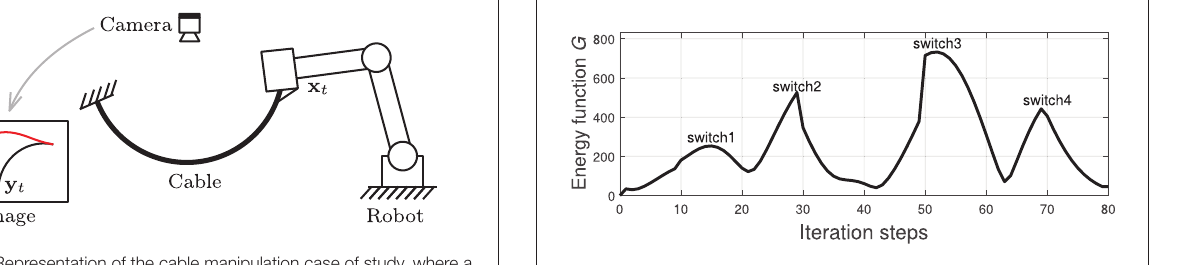
The cable simulation code is publicly available at https://github. com/Jihong-Zhu/cableModelling2D.